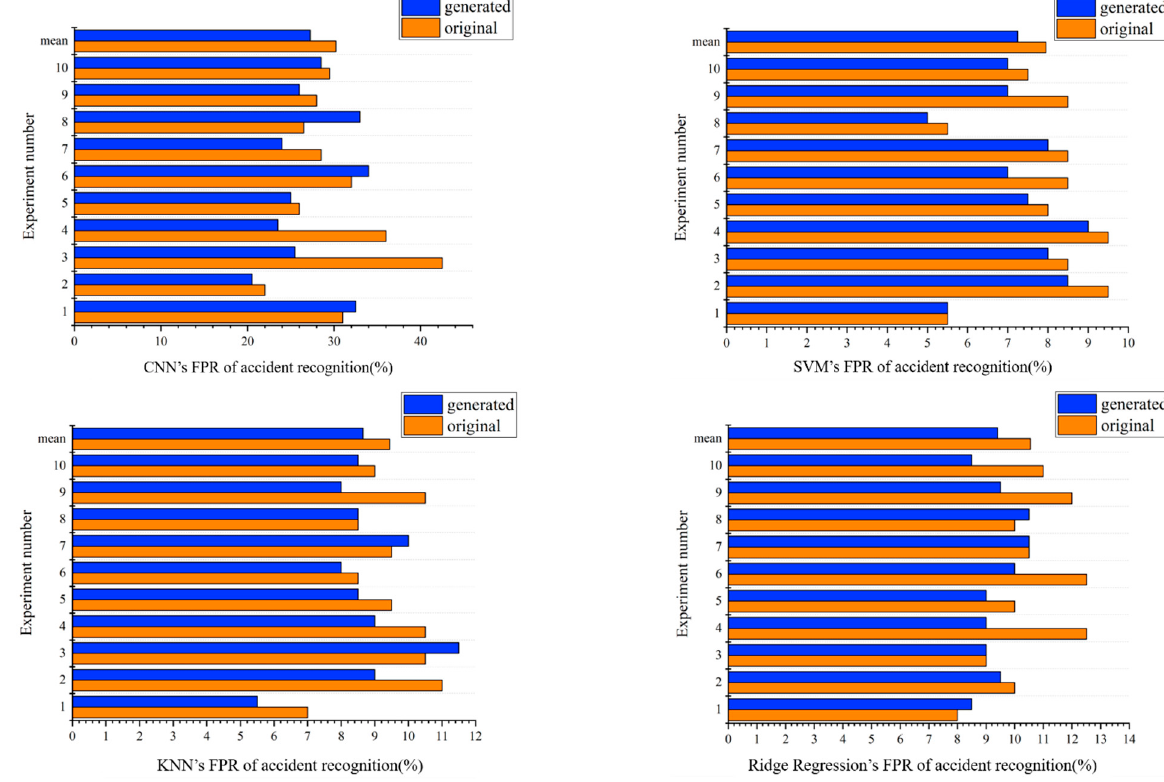
Figure 6. Comparison of FPR of accident recognition across classifiers trained on different datasets. The “generated” in the figure represents the “original + generated” data.